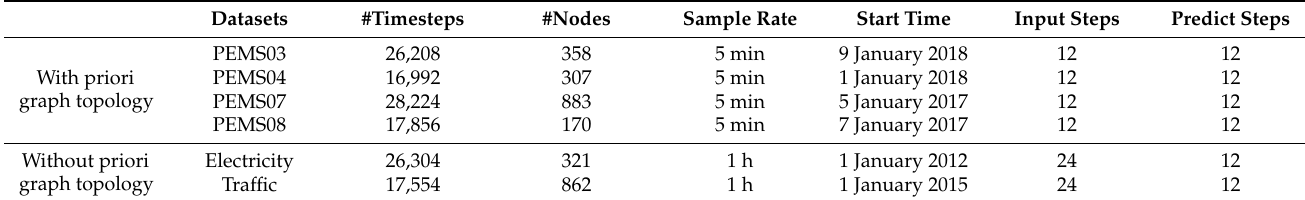
Table 1. Dataset description and